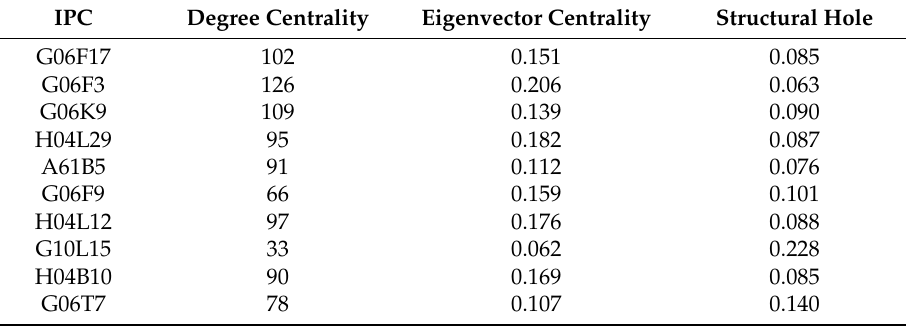
Table A2. Centrality indicators of the Top 10 IPC codes with the highest